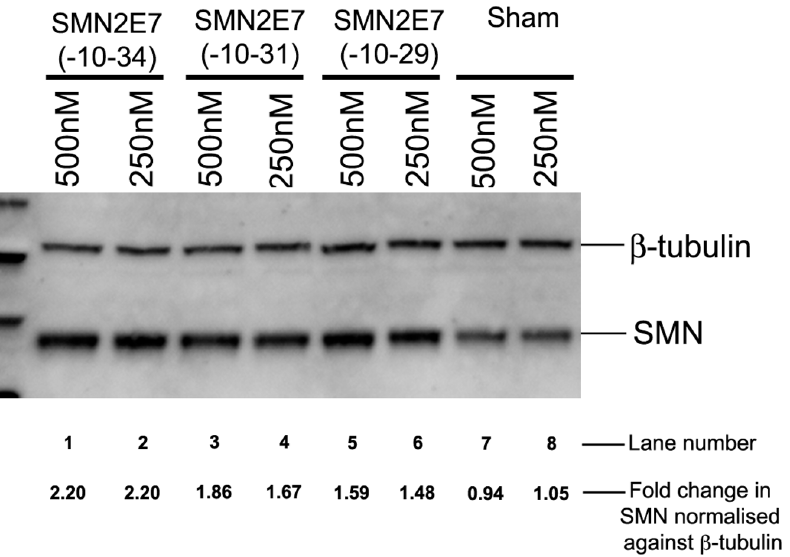
Figure 6. Western blot analysis of SMN in type I SMA patient fibroblasts nucleofected with PMOs or unrelated negative control (Sham PMO). The fold change in SMN expression, normalised against ß-tubulin is shown.